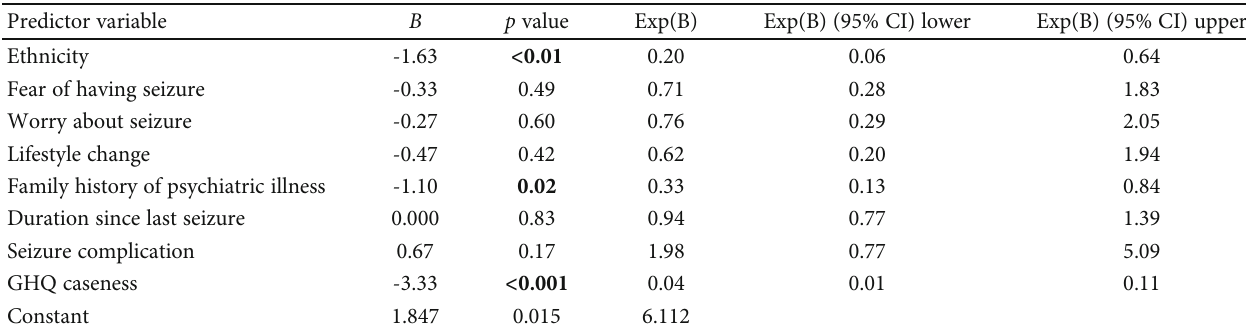
Table 4: Logistic regression analysis for the predictors of depression in the